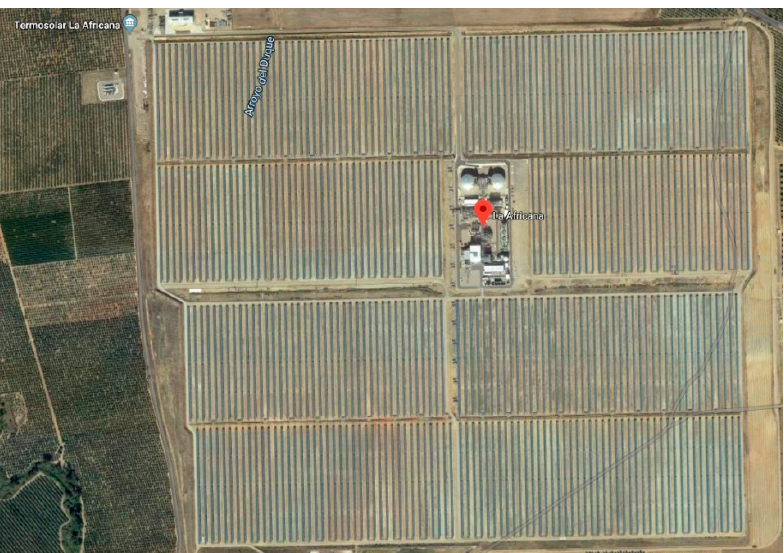
Figure 1. View of solar cylinder parabolic collectors at the Solar Thermal Power Plant “La Africana” (“satellite” view from googlemaps.com).